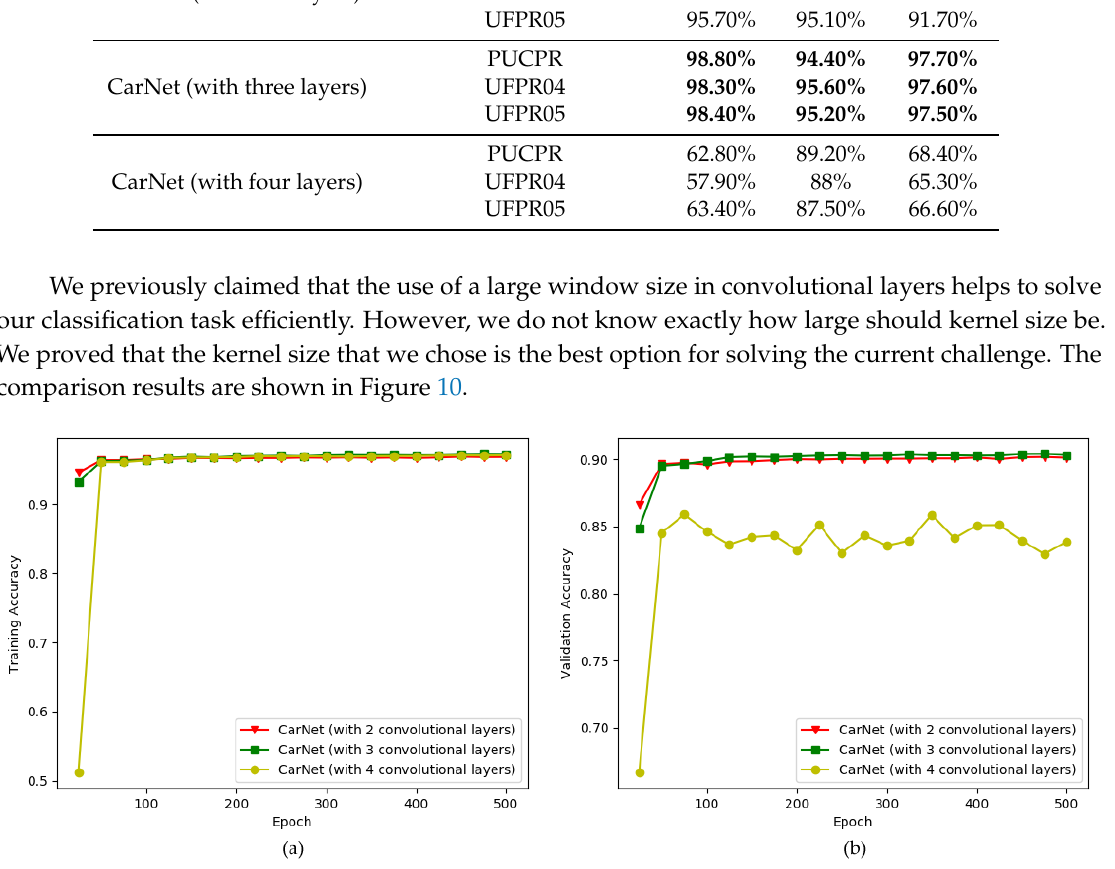
Figure 11. Comparison of CarNet (with two layers), CarNet (with three layers) and CarNet (with four layers). x-direction: number of epochs (500), y-direction: accuracy. ( a ) training accuracy; ( b ) validation